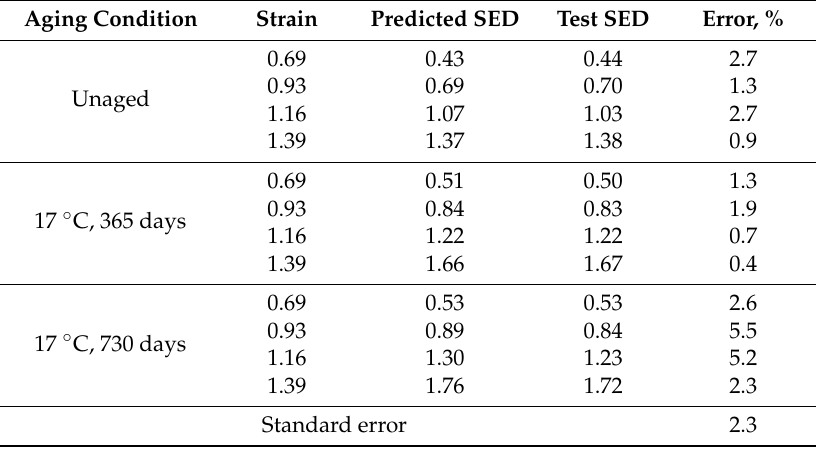
Table 7. Comparison of SED values according to experimental and crosslink master curves. Aging Condition